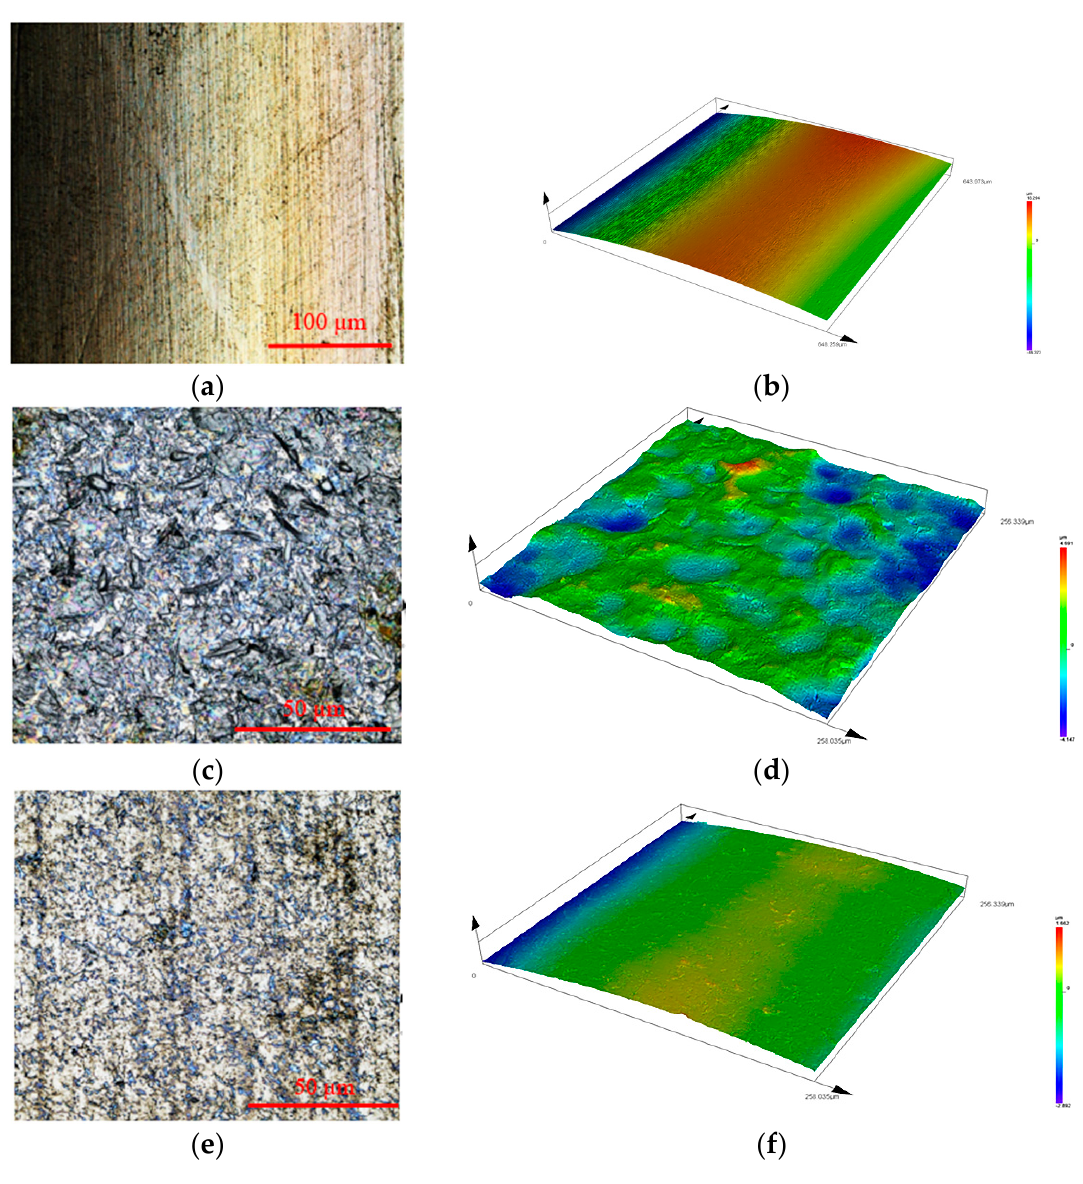
Figure 6. ( a – f ) The surface topography and height of Polishing, AWJP, and AWJP + USRE.